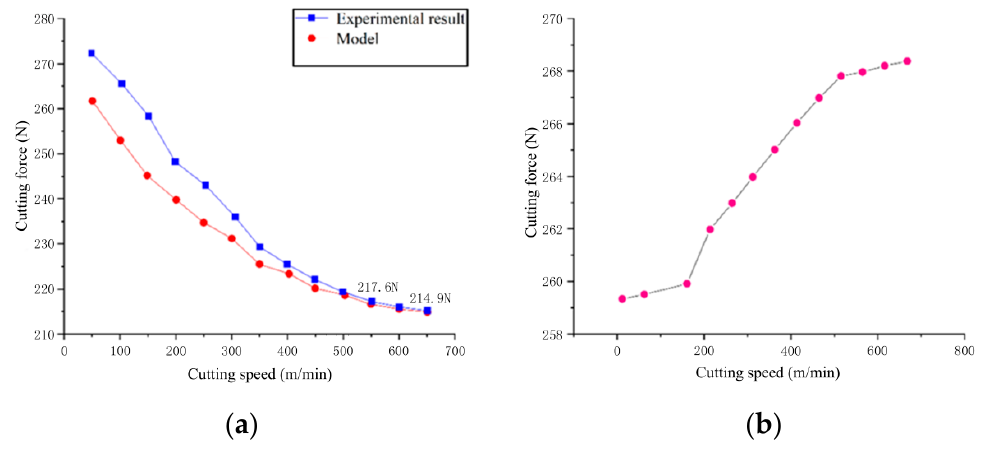
Figure 5. Changing trend of cutting force. ( a ) Cutting force prediction in EVC cutting; ( b ) Cutting force in conventional cutting SiCp/Al.